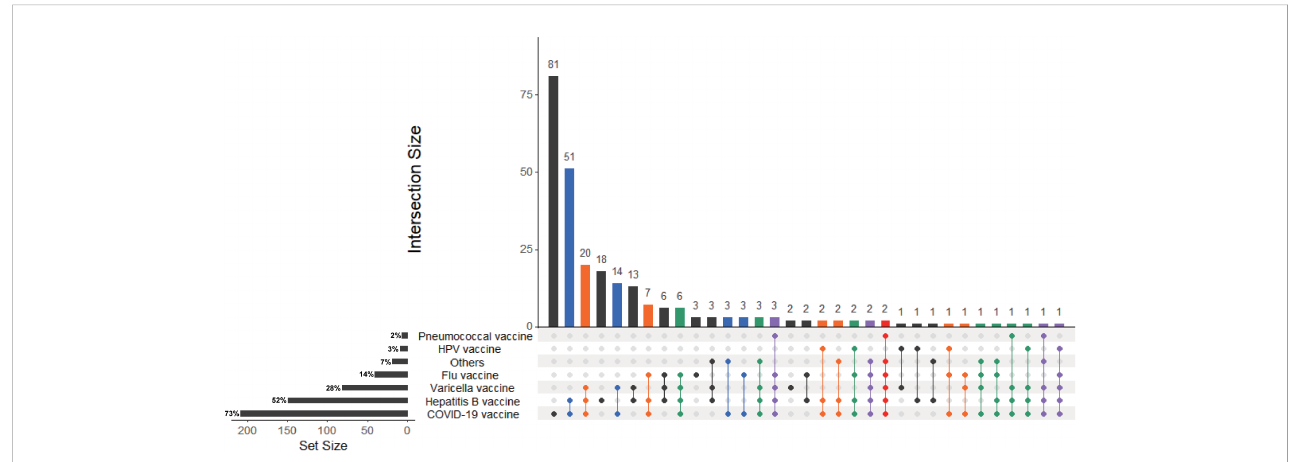
FIGURE 2 UpsetR plot of IBD patients received COVID-19 vaccines or inoculated other vaccines in the previous year. The UpSetR plot was created for IBD patients who received COVID-19 vaccines or inoculated fl u vaccine, hepatitis B vaccine, pneumococcal vaccine, varicella vaccine, cervical HPV vaccine and other vaccines in the previous year. The horizontal bars with labels at the lower left of the panel represent the seven data sets of patients who received different vaccines, with the length of each bar displaying the total set size. The dot pattern to the right shows the intersections between the sets. The vertical bars at the top show the size of the corresponding intersection, ranked by decreasing set size, where a gray dot indicates an empty set and a single black dot indicates no intersection with another